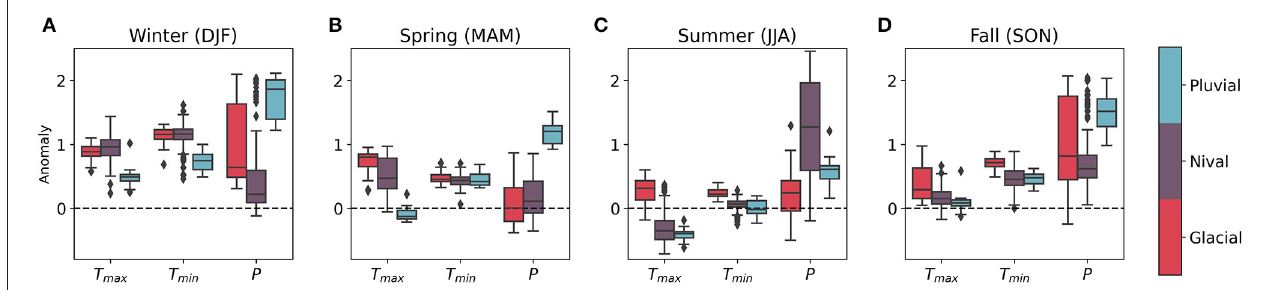
FIGURE 6 | Daily anomalies of maximum temperature, minimum temperature, and precipitation, preceding the largest day-to-day modeled flow increases in (A) winter, (B) spring, (C) summer, and (D) fall. Results are presented by streamflow regime (pluvial, nival and glacial). The dashed black line indicates zero (or average) values. Positive values indicate warmer or wetter than average, while negative values indicated colder or drier than